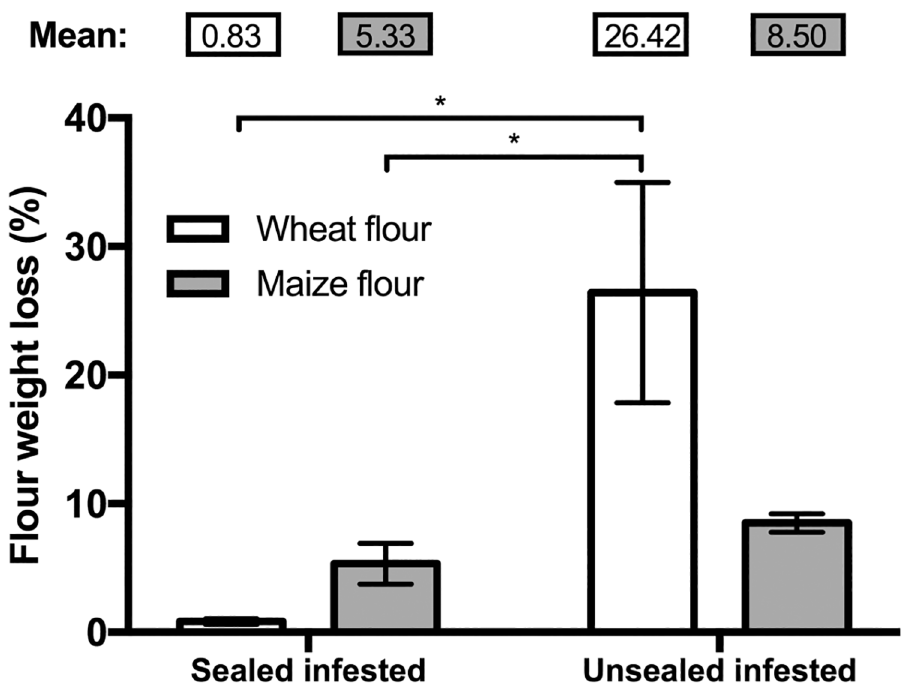
Fig 3. Flour weight loss caused by red flour beetle (RFB). Sealedinfested bottles saw little weight loss over the study period, while loss of wheat flour mass in the unsealed infested group was significantly higher than in the other infested groups(Sealedcondition:F (1, 8) = 10.79, P = 0.0111; Flour type: F (1, 8) = 2.35, P = 0.1638). Columnheightsrepresent the mean and the error bars represent the standarderror of the mean. “ * ” representsP <